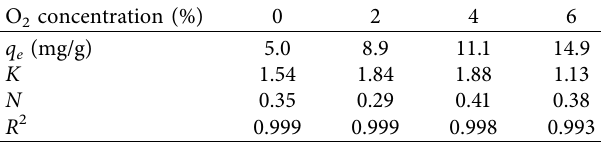
Table 5: The parameters of Bangham model of Figure 8(b). O 2 concentration (%)